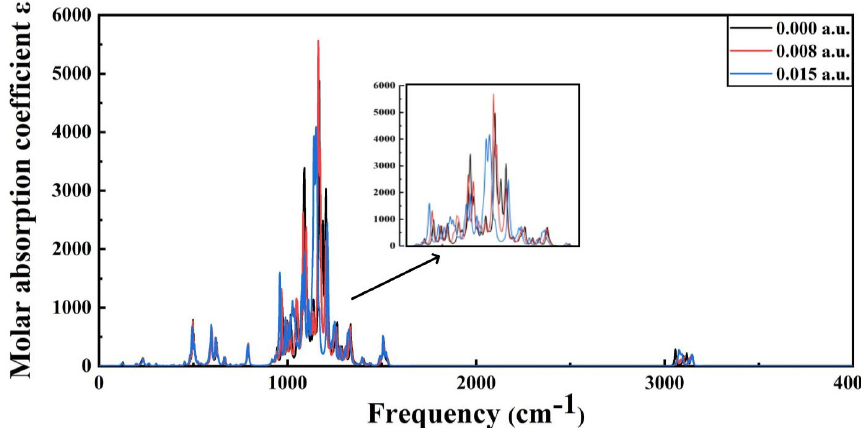
Figure 12. The infrared spectra of PVDF at 0 a.u. to 0.015 a.u.